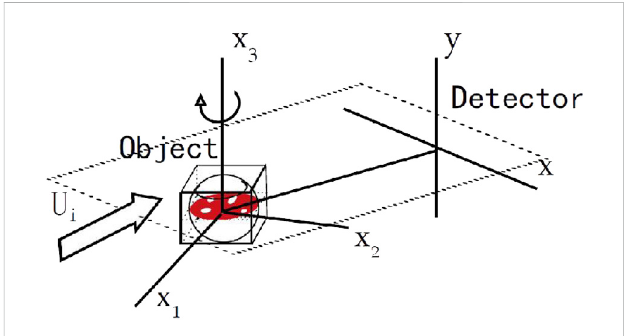
FIGURE 1 Coordinate system for the object and the plane of